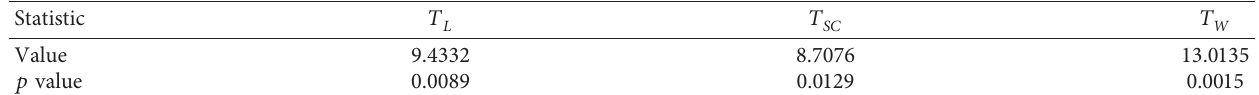
Table 13: Test statistics’ values and p values.